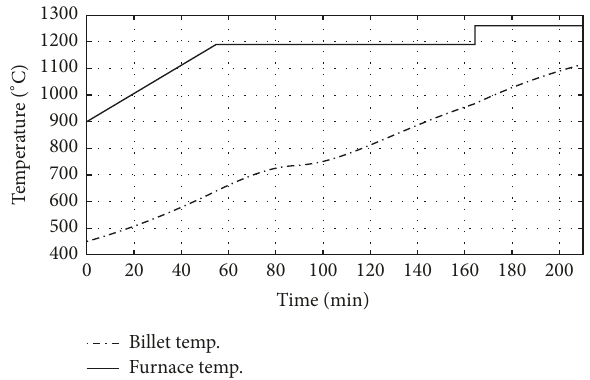
Figure 3: Actual internal temperature and temperature set by the model for heating zone.